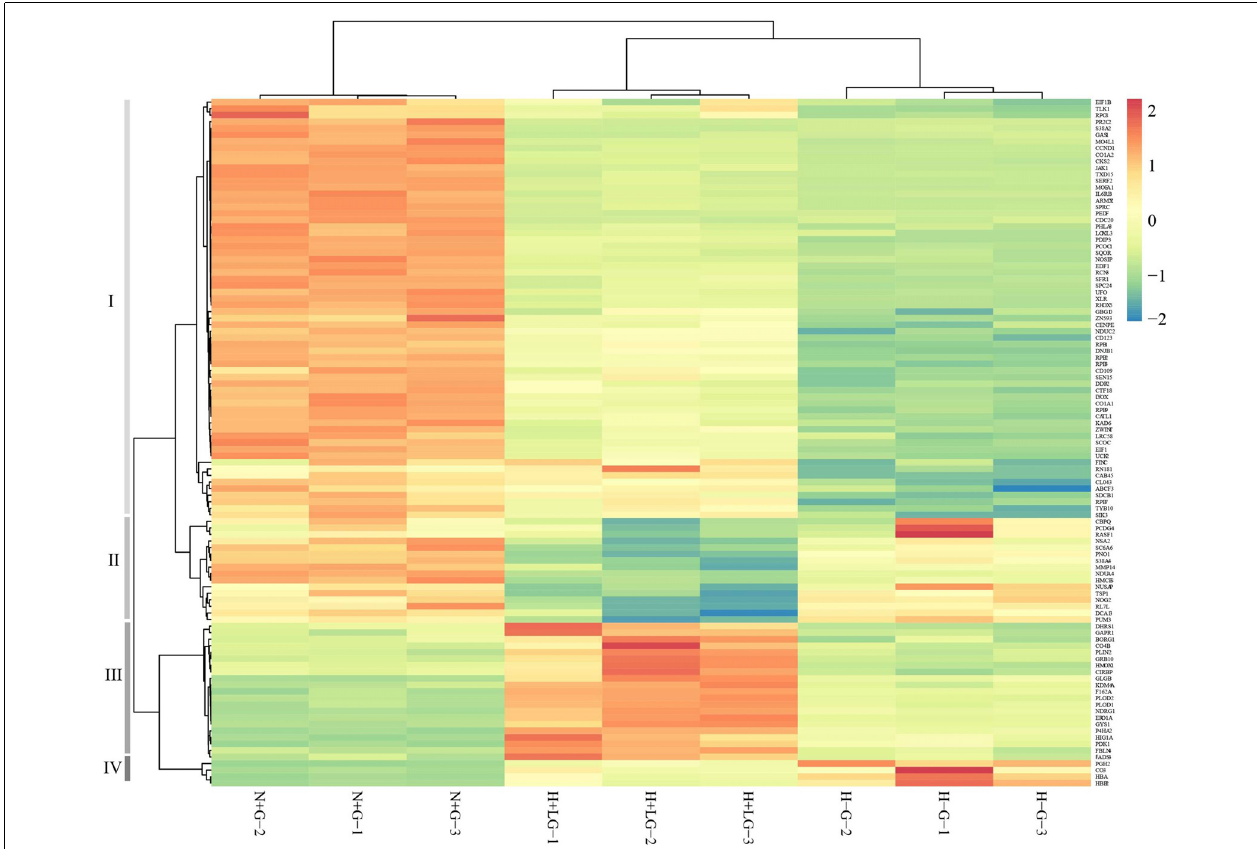
FIGURE 8 | Heat map from hierarchical clustering of 105 DAPs between H − G and H+LG treatments. Abundances of these 105 proteins from N+G treated cells were also included for clustering analysis. DAPs are clustered into four groups (I to IV) based on abundance similarity. The color key scale bar at the upper right shows Z-score values for the heat